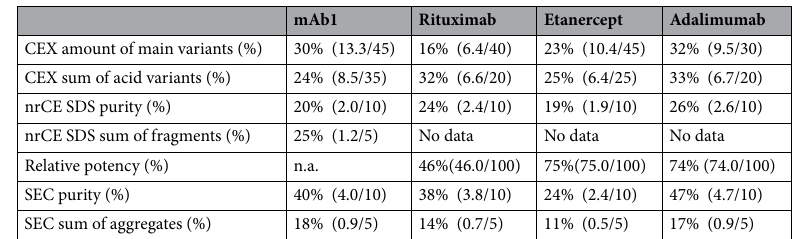
Table 2. Determined prediction interval widths relative to the current state-of-the-art mAb platform specifications for drug products 48 . Values in brackets are an average of width of calculated model-based prediction intervals divided by the width of the mAb platform specification. The widths of model-based prediction intervals are given at 36 months as obtained from fitting of 6 months short-term stability study data. These prediction interval widths were calculated from exactly the same data set as the prediction accuracies shown in Table 1.